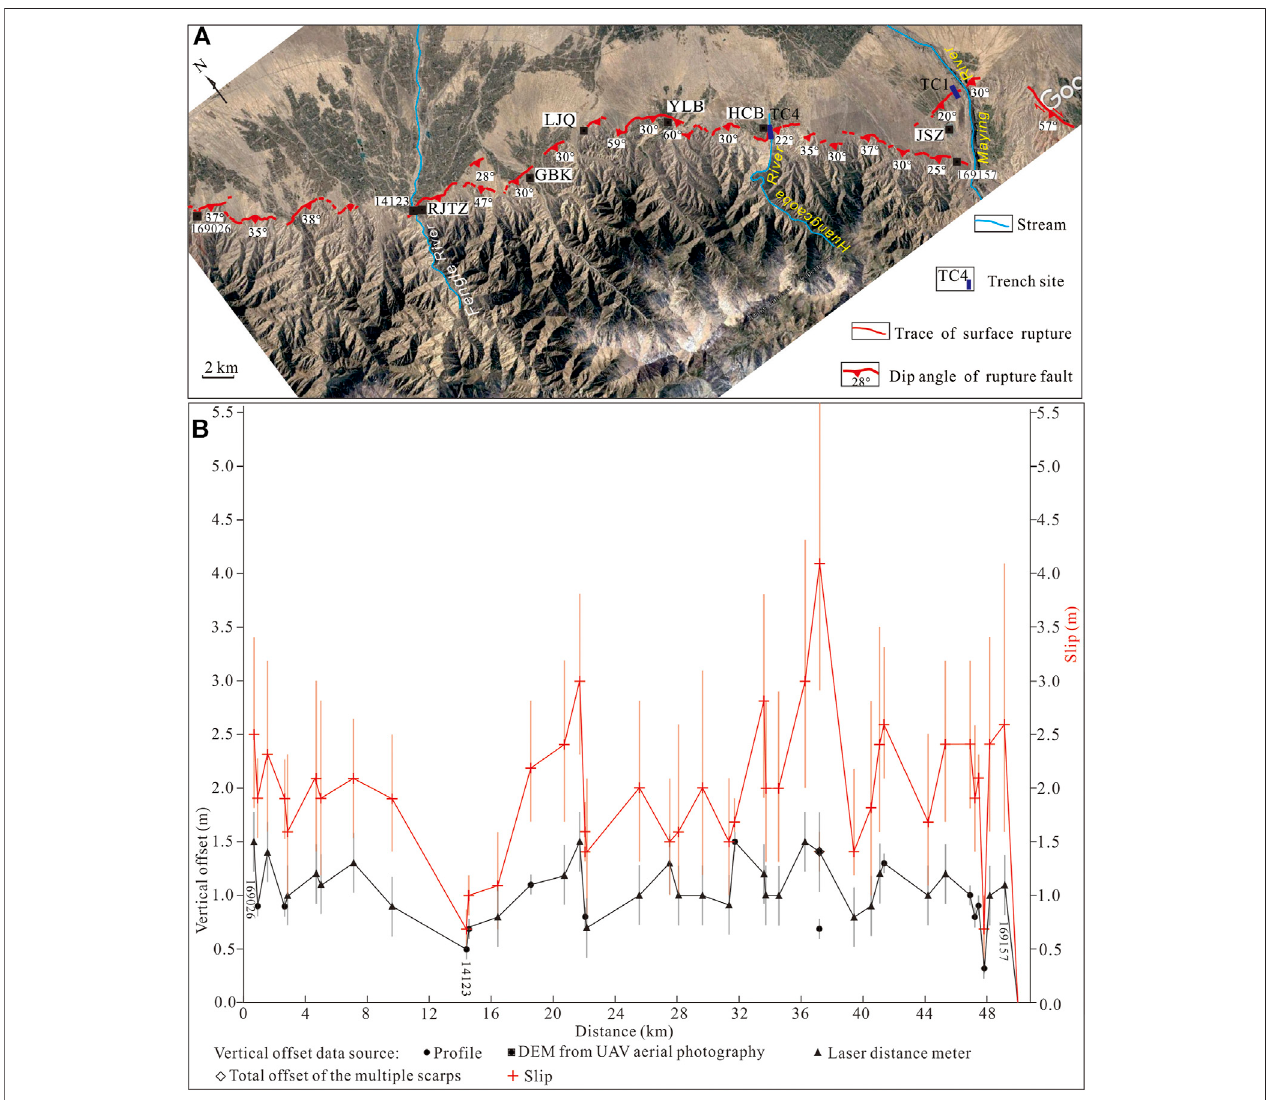
FIGURE 11 | (A) Map of the 1609 surface rupture in the middle segment. Place names: JFS, Jinfosi; GBK, Ganbakou; LJQ, Luejiaquan; YLB, Yulinba; JSZ, Jiashanzi. (B) Offset and slip of the 1609 earthquake in the middle segment.